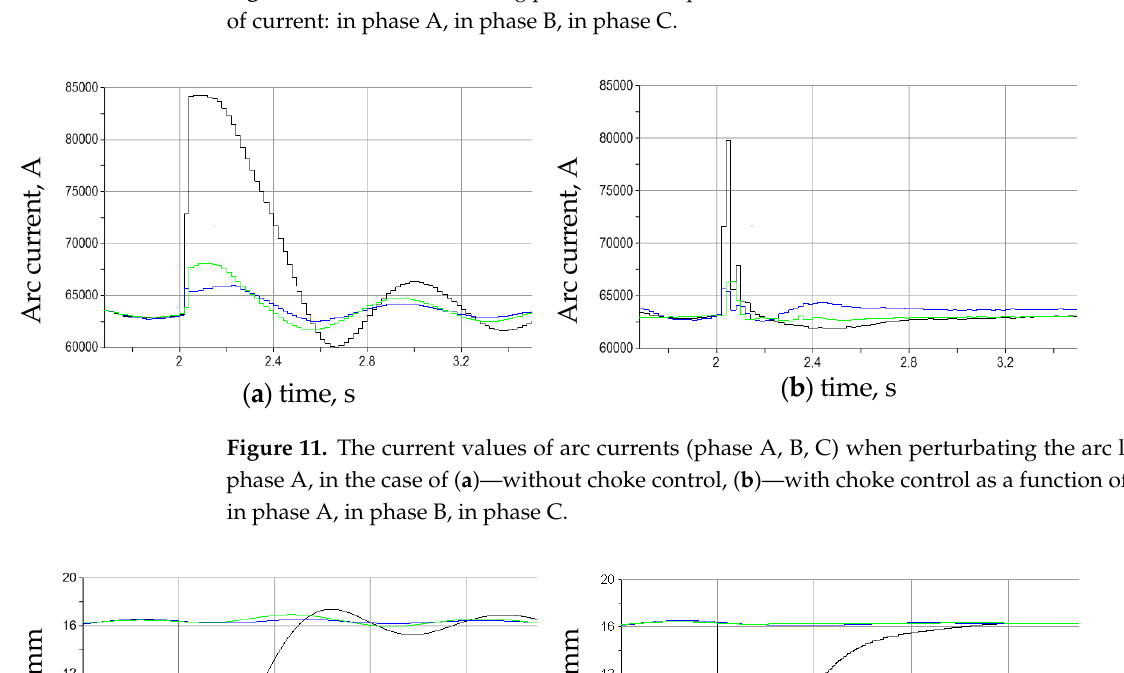
Figure 10. Arc currents during perturbation in phase A and in the case of choke control as a function of current: in phase A, in phase B, in phase C.